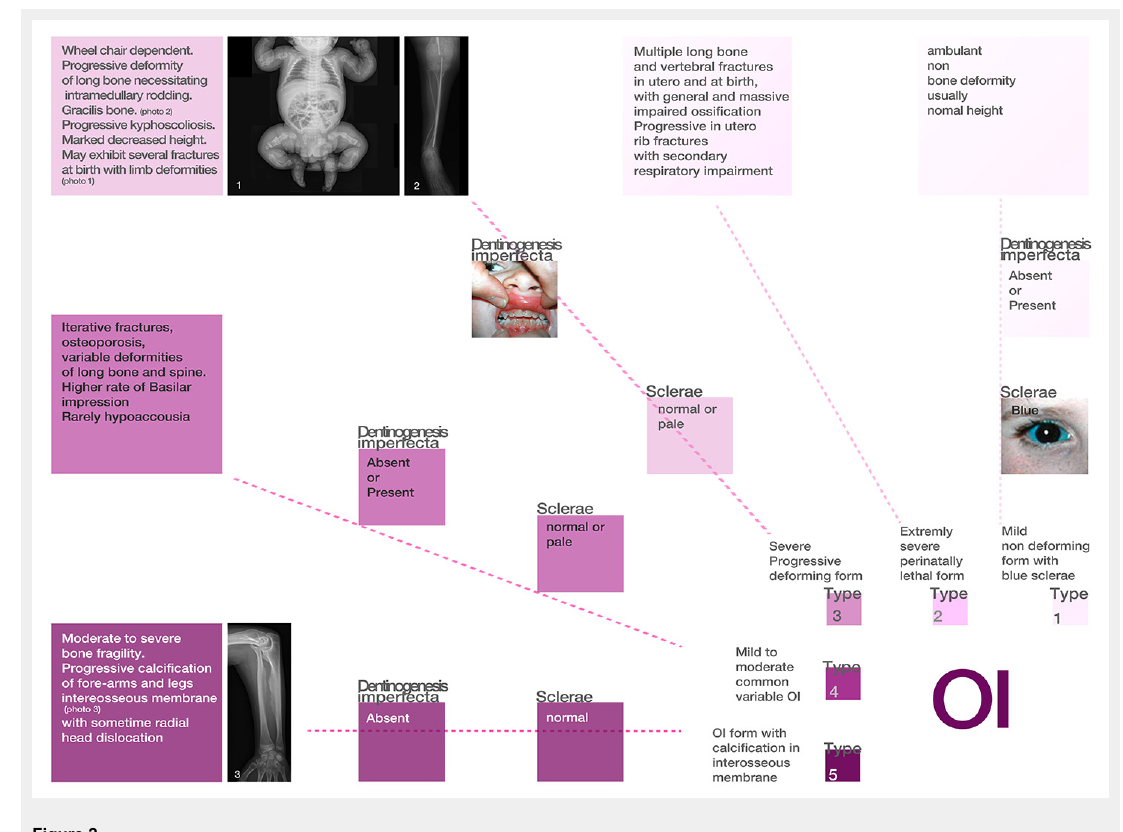
Figure 2 Characteristics of osteogenesis imperfecta (OI) types 1–5, illustrating morphological features for each